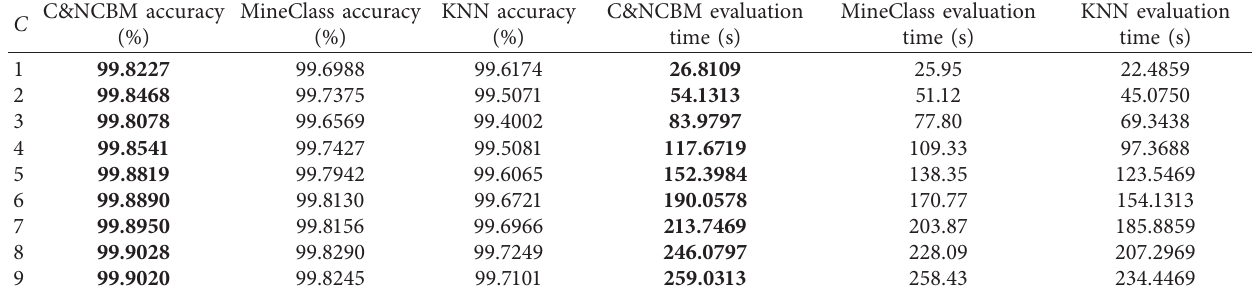
Table 4: Experimental result data in KDD Cup dataset.